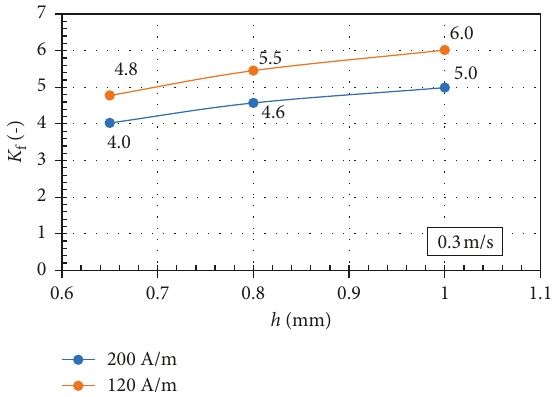
Figure 25: Turn-up ratio variation with gap height and coercivity, V � 0 . 3m/s. r